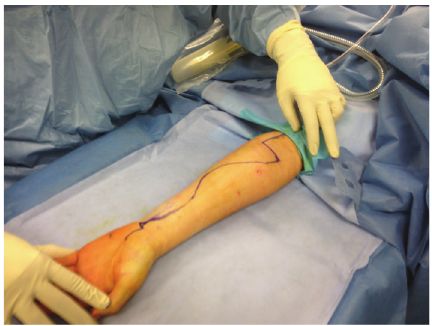
Figure 6: The volar S shaped incision including proximal palm to decompress carpal